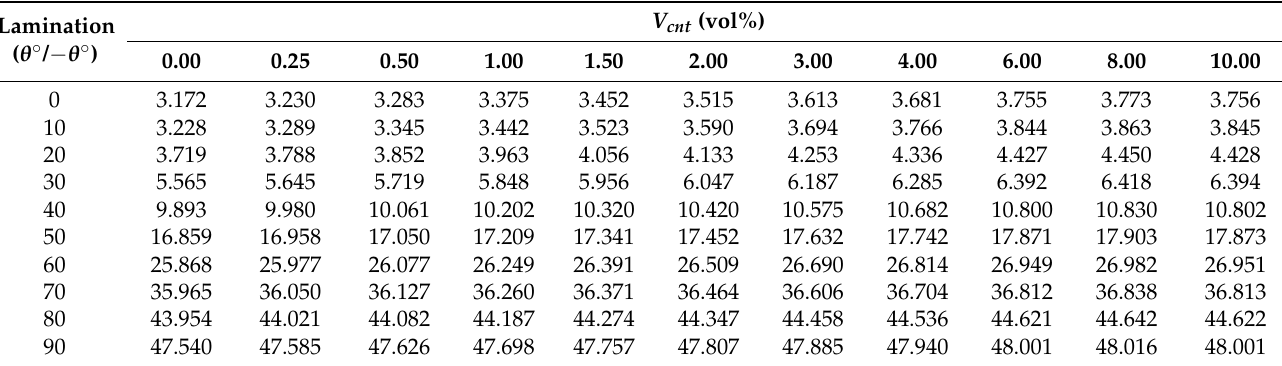
Table 8. Critical buckling load (N/mm) of the present study with material properties taken from Table 2 for different V cnt values